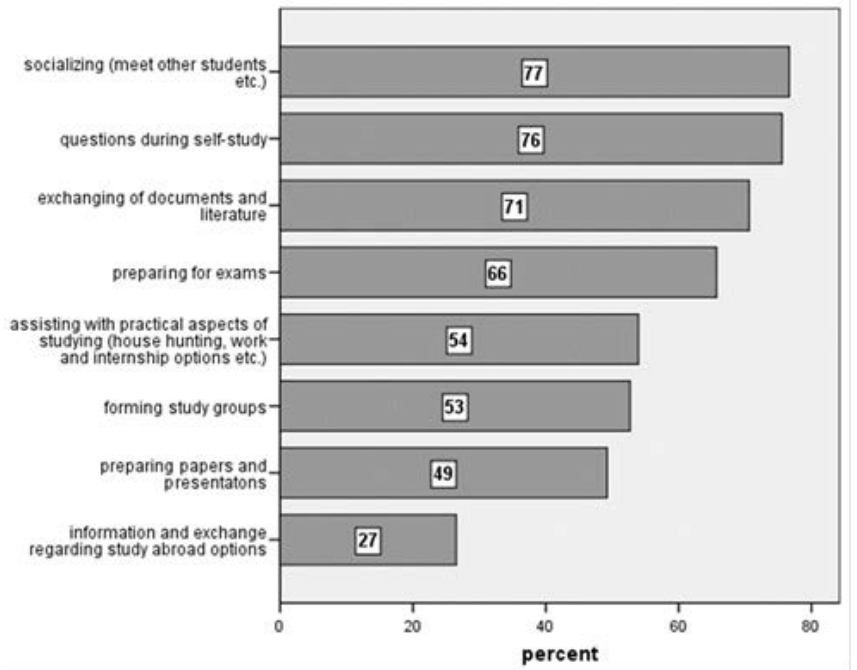
Figure 1 . Social networks in university (multiple responses, distribution in